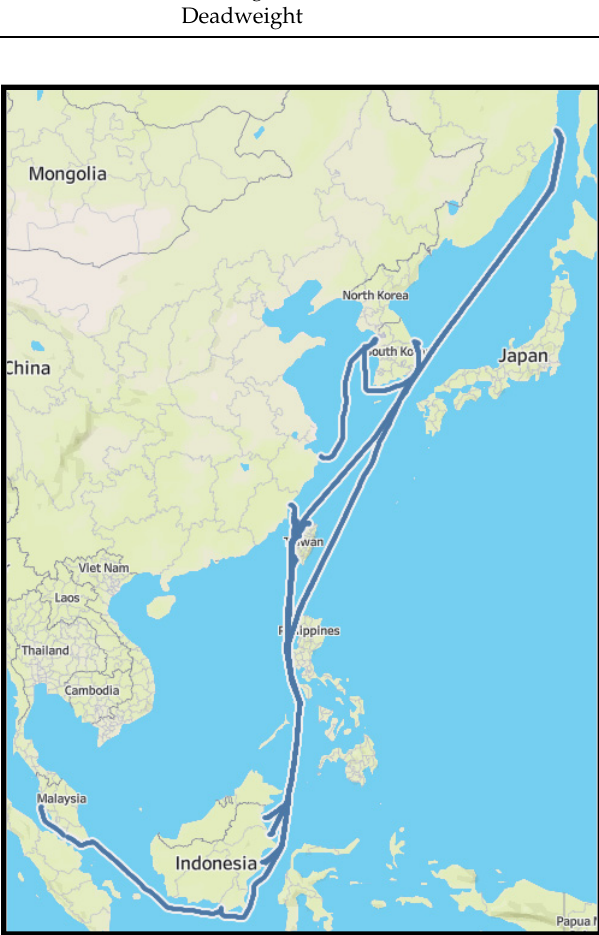
Figure 1. Vessel routes trajectory.